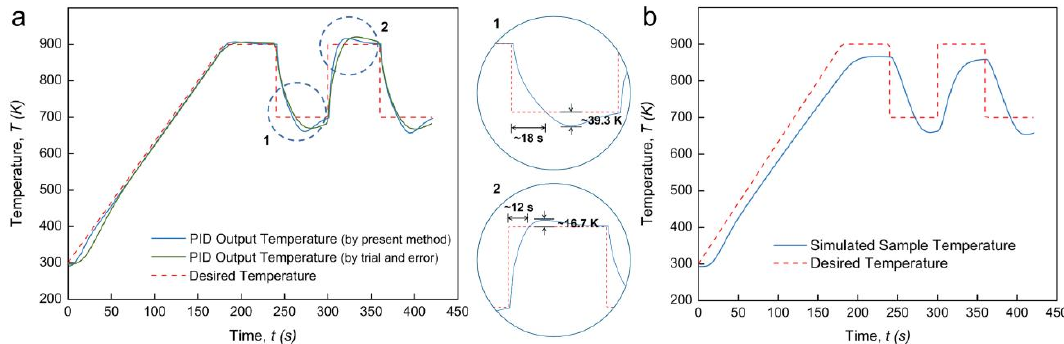
Figure 7. PID regulation outcome for non-continuous temperature profile: ( a ) PID output temperature profile with enlarged views; ( b ) simulated sample temperature profile.